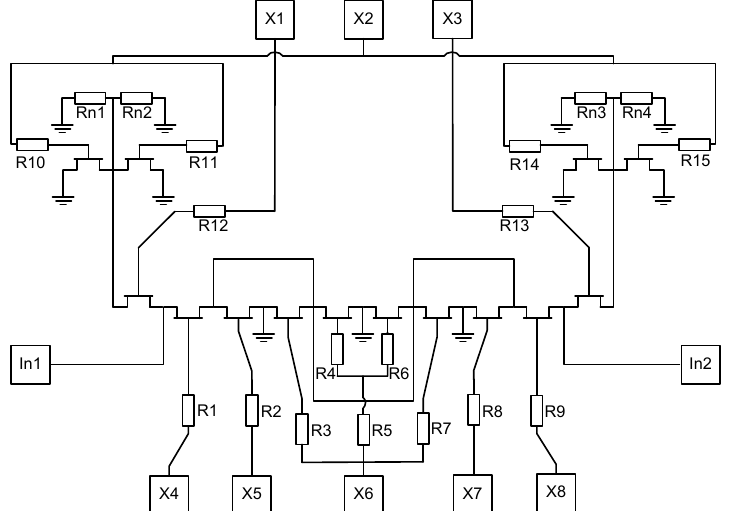
Fig 2 . Electrical circuit of electronic calibrator